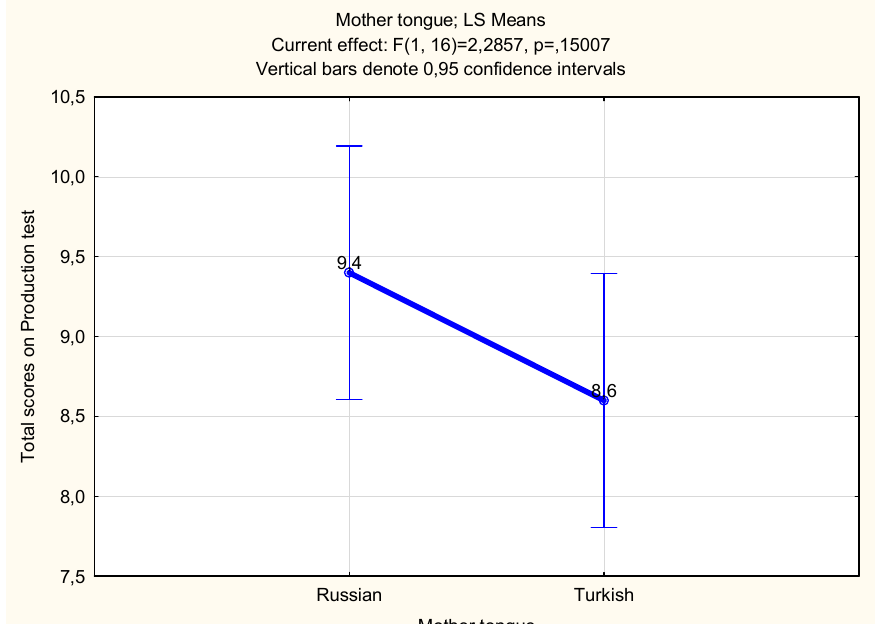
Fig. 2 – Total scores on Production Test as a function of Mother